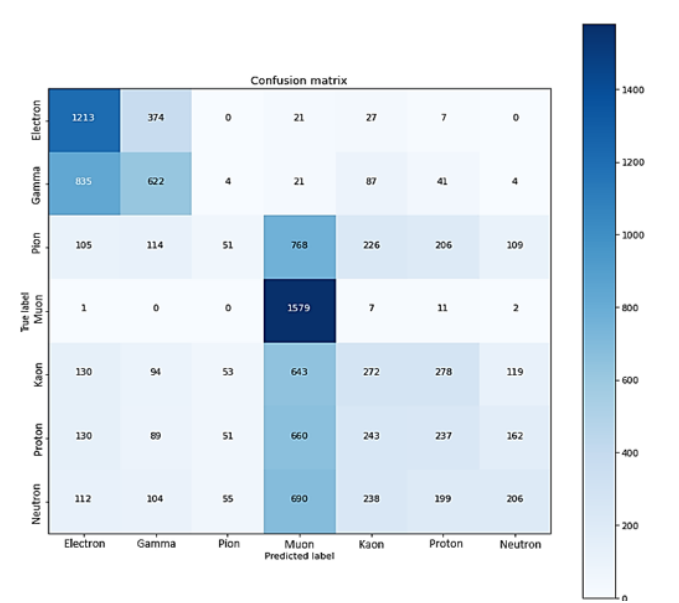
Figure 6. Confusion matrix: 11,200 samples without charge di ff erentiation.